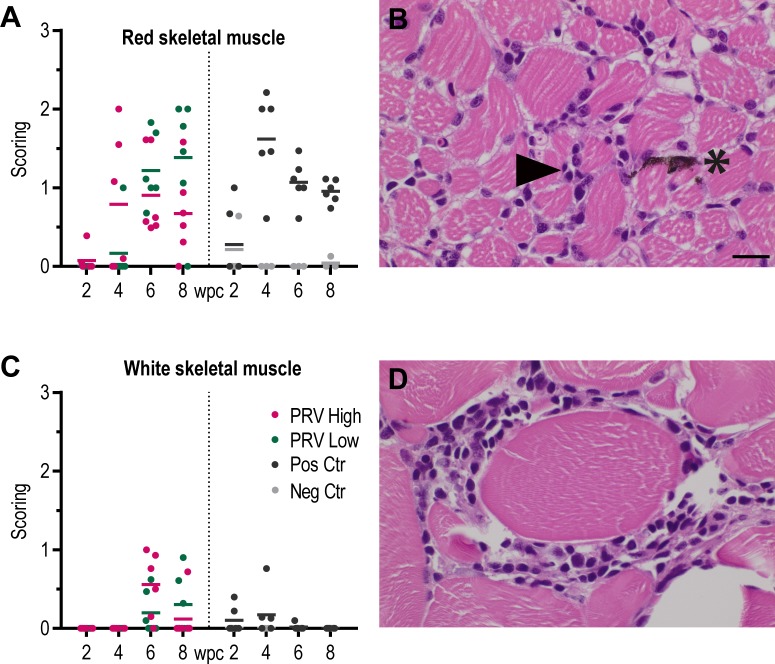
Histopathological lesions consistent with HSMI detected in skeletal muscle.Histopathology in the skeletal muscle of fish injected with purified PRV in challenge experiment #2. (A) Histopathological score in red skeletal muscle shown as individual and mean score from 2 to 8 weeks post challenge (wpc) for the PRV-High (red), PRV-Low (green), positive control (black) and negative control (grey) group (n = 6). Statistical analysis comparing PRV-High and PRV-Low was performed using Mann-Whitney test at each time point, p < 0.05. No significant difference observed. (B) Light microscopic image of red skeletal muscle, 6 wpc, PRV-Low group. Mild myositis (arrowhead) and presence of melanin (*). Scale bar 10 μm. (C) Histopathological score in white skeletal muscle shown as individual and mean score, presented as for red skeletal muscle. (D) Cross section of white skeletal muscle, 6 wpc, PRV–High; Mild inflammation around white muscle fiber.